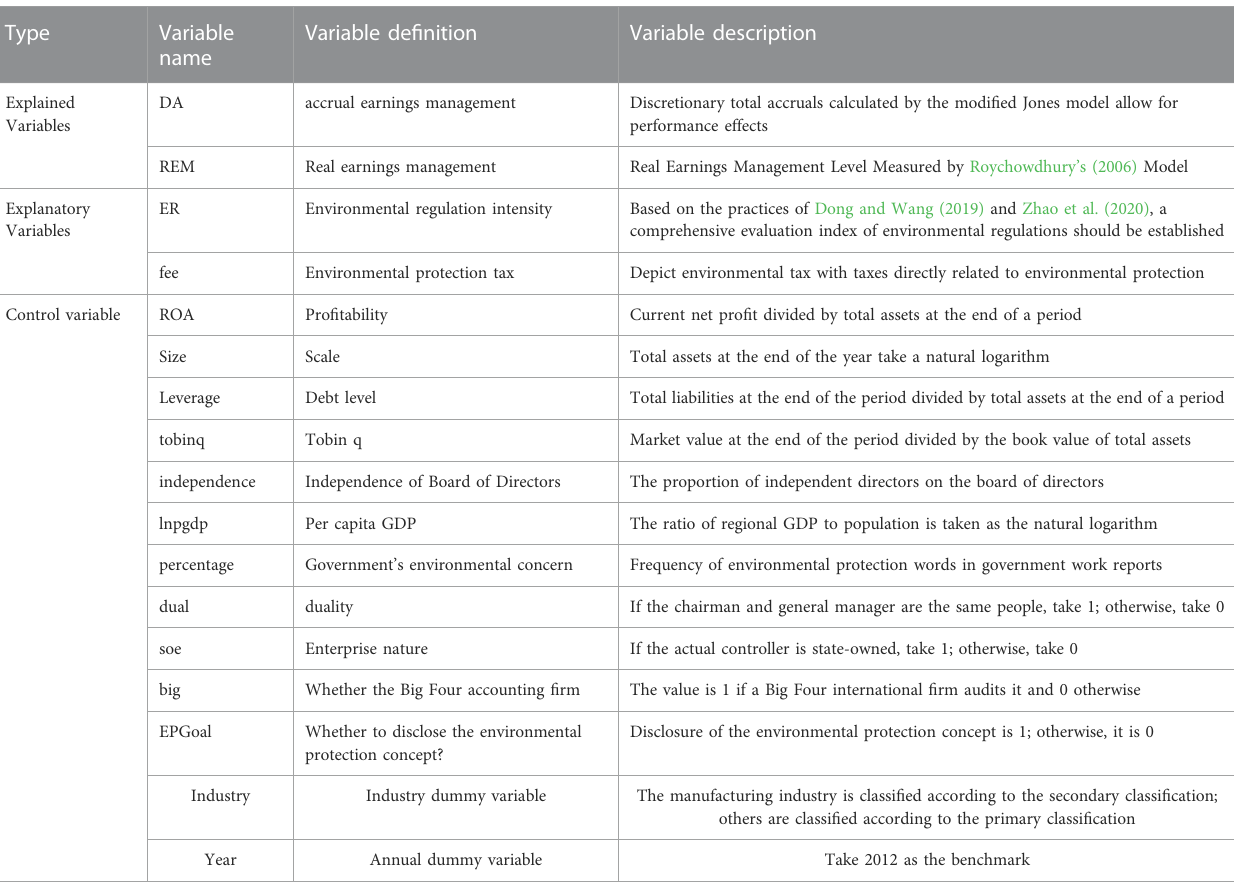
TABLE 2 De fi nition of